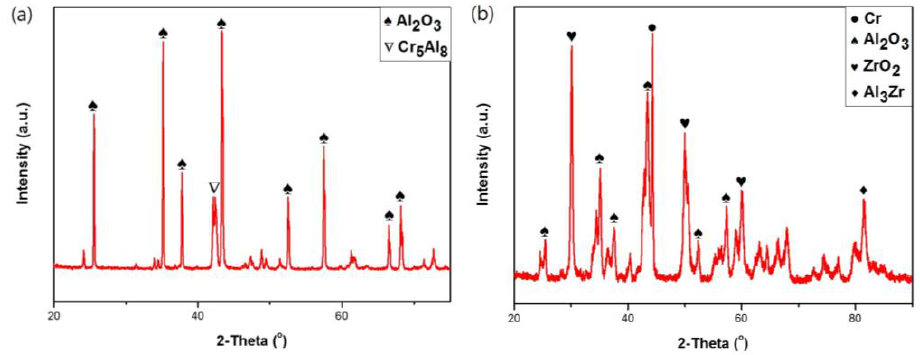
Figure 9. XRD analyses of cast specimens after the steam oxidation test at 1200 ◦ C for 1 h: ( a ) Cr-30%Al; ( b ) Cr-30%Al-20%Zr alloy.